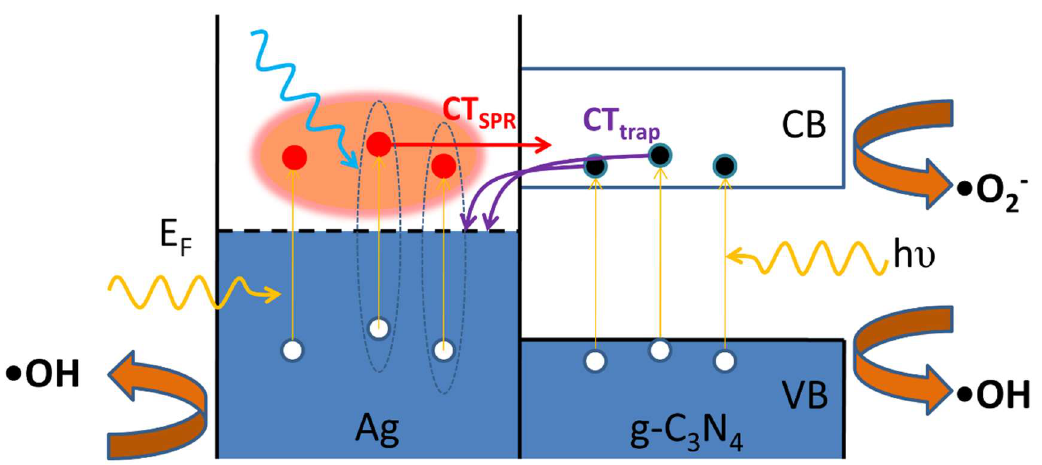
Figure 5. Charge transfer pathways through g-C 3 N 4 /Ag heterojunctions and the generation of active